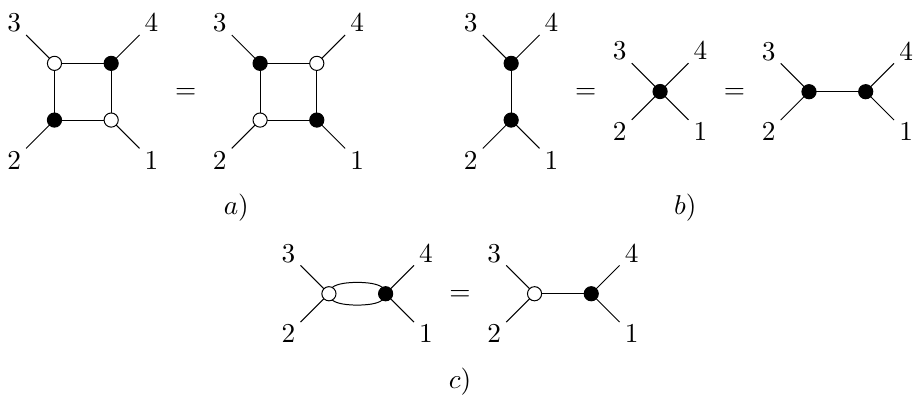
Figure 2 . Equivalence moves for on-shell diagrams: a) square move, b) merge/unmerge move for black nodes (similar for white nodes), c) bubble